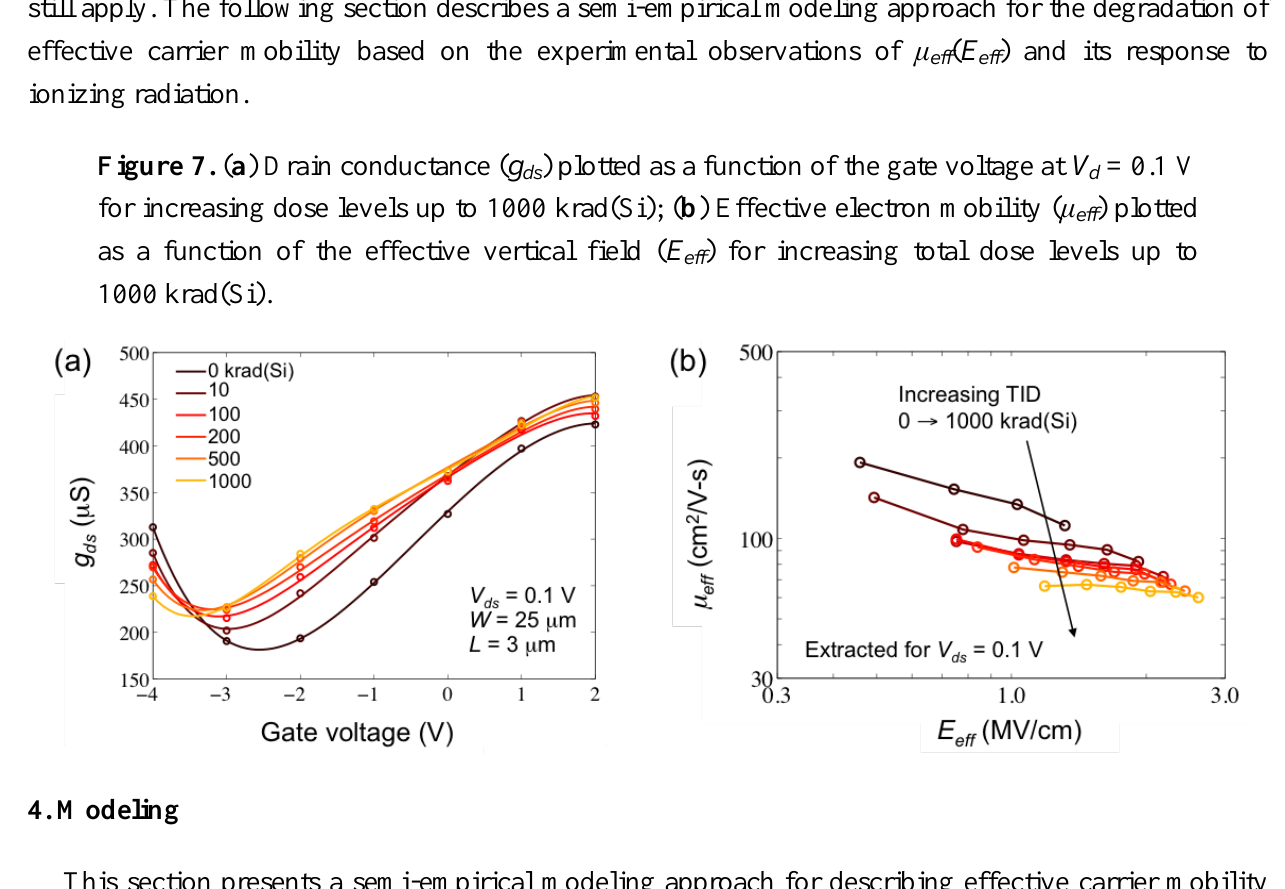
= 0.1 V d ) plotted eff